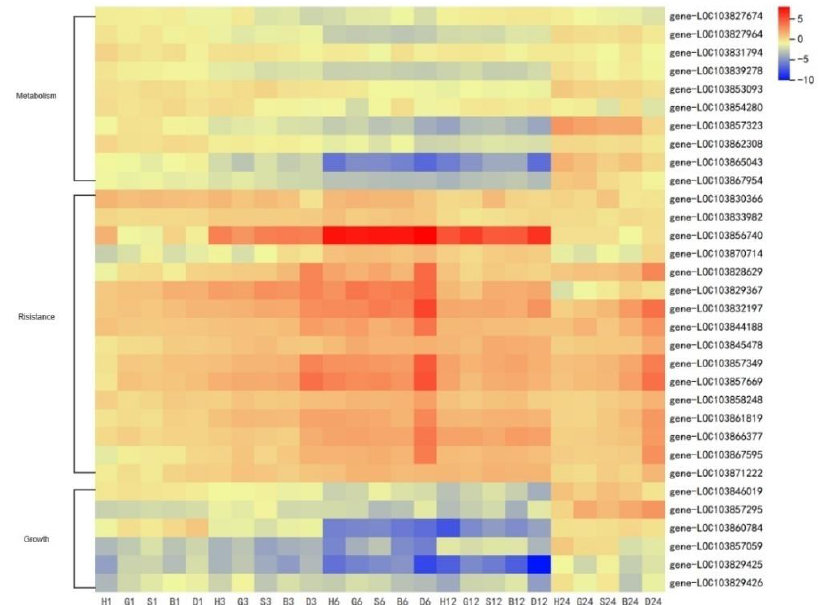
Figure 9. DEGs of metabolism, resistance, and growth response to spraying treatments at 1, 3, 6, 12, and 24 h. Heat map represents the value of DEGs as L2FC relative to CK (0 h) (H, H 2 O treatment; G, GSH treatment; S, GSSG treatment; B, BSO treatment; D, DTT treatment).